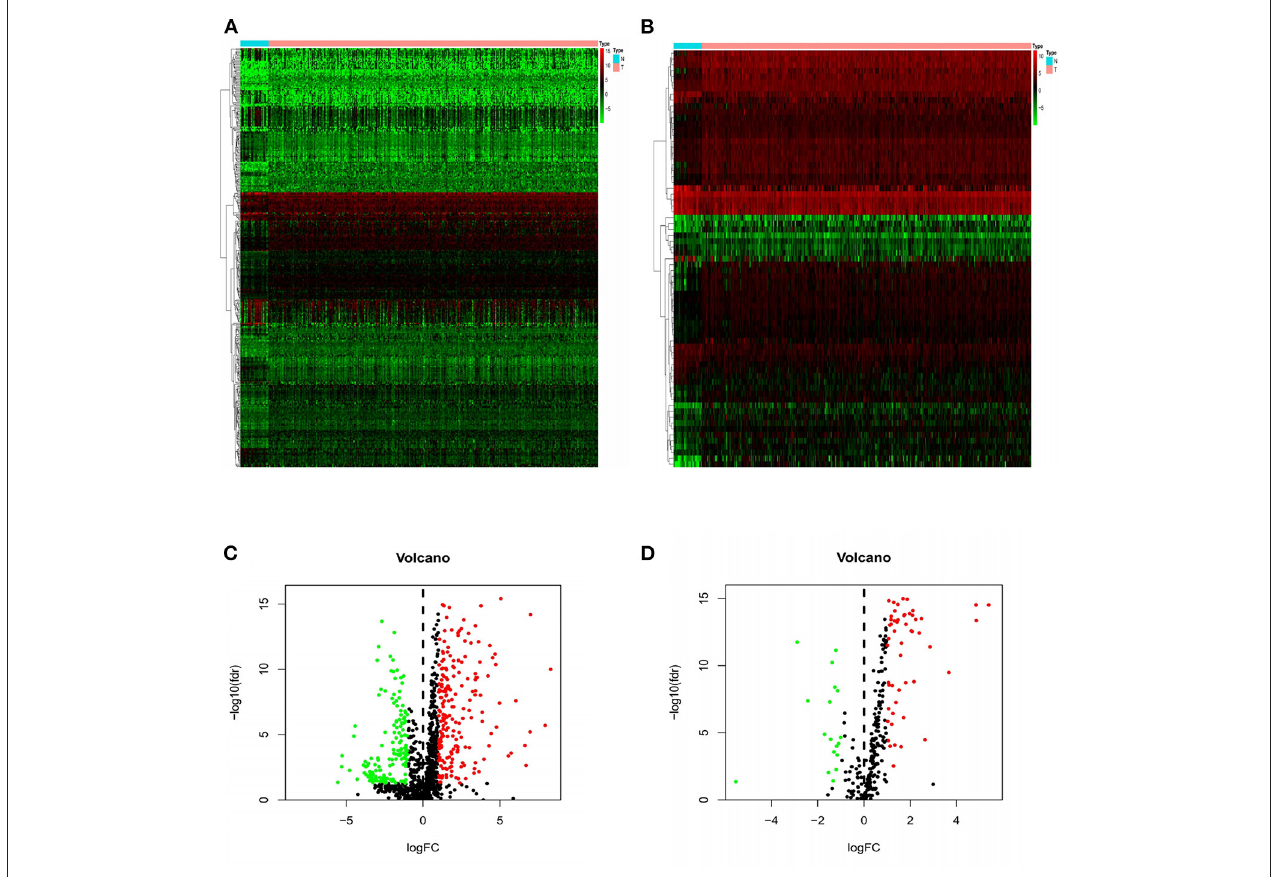
FIGURE 1 | Heat maps and volcanic maps of IRGs and TFs expression. The differential expression heat maps of IRGs (A) and TFs (B) . The differential expression volcanic maps of IRGs (C) and TFs (D) . The heat map abscissa represents the sample: the blue area represents normal tissue and the red area represents tumor tissue; the ordinate represents the gene. On the volcano map, the green area represents the down-regulated differential genes and the red area represents the up-regulated